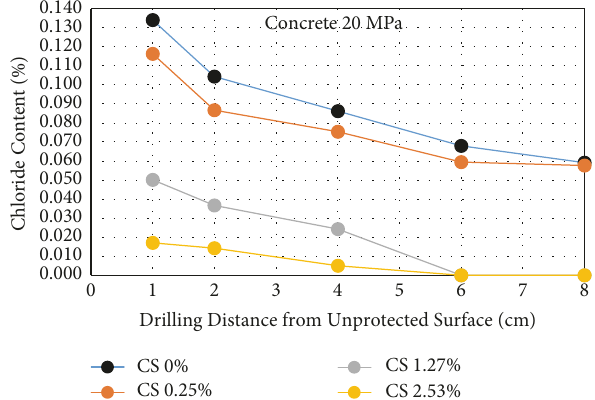
Figure 10: Chloride content in 20 MPa concrete.